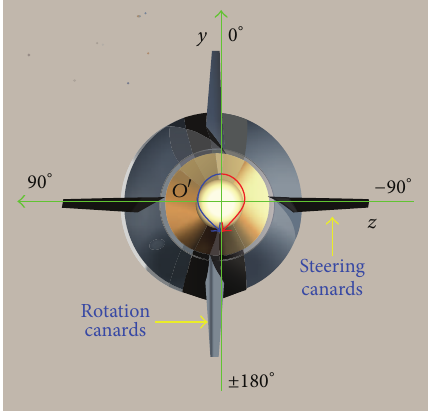
Figure 1: Sketch map of correction